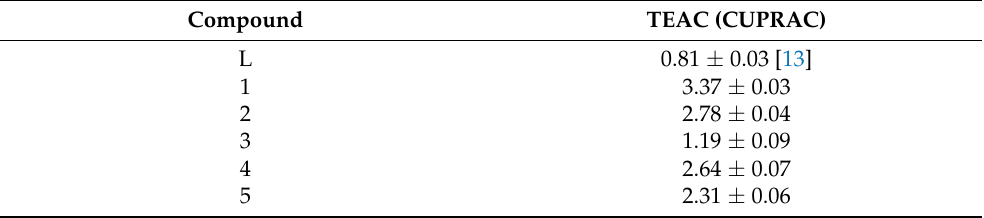
Table 3. The TEAC values of Cu 2+ reducing activity in CUPRAC test for compounds L , 1 – 5 . Compound